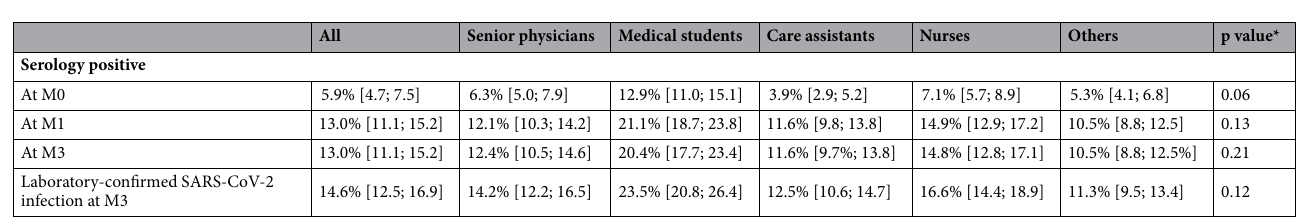
Table 2. Laboratory-confirmed infection with SARS-CoV-2 at month 3 (M3) and seroprevalence at M0, M1 and M3 after imputation of missing data, according to professional category. Data are % (95% confidence interval). Others include (but not limited to): secretaries, nurse’s managers, social workers. *Comparison across professional